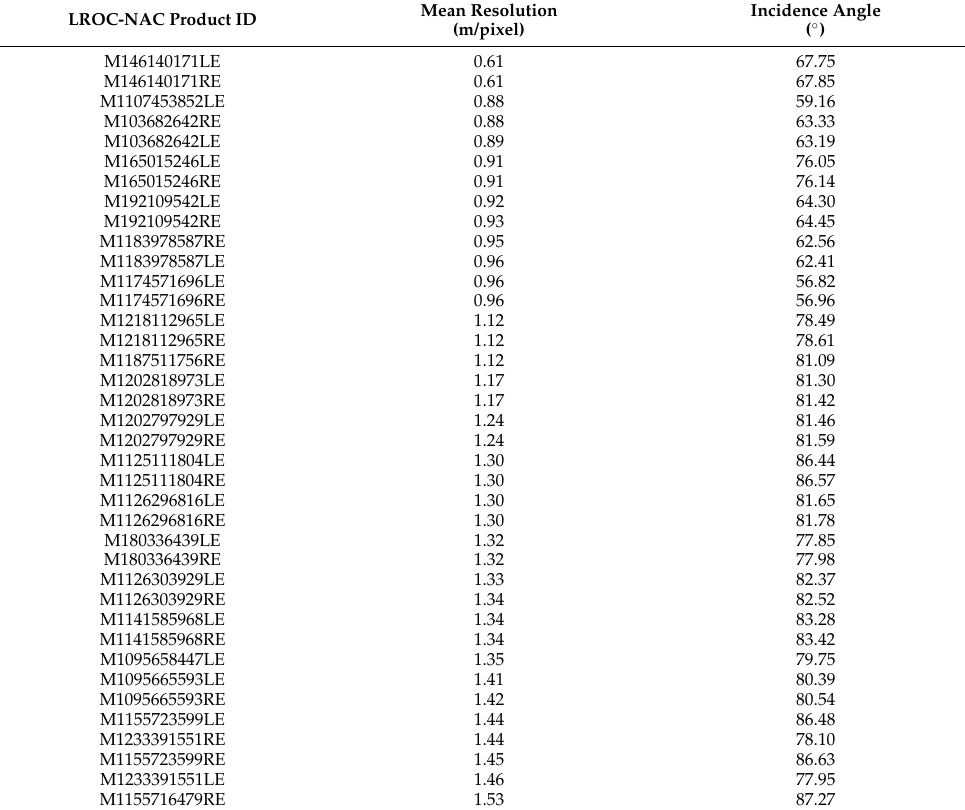
Table A1. List of Lunar Reconnaissance Orbiter Narrow Angle Camera (LROC-NAC) [30] images used for the crater size–frequency distribution (CSFD) measurements with relative mean resolution and incidence angle enlisted in ascending resolution